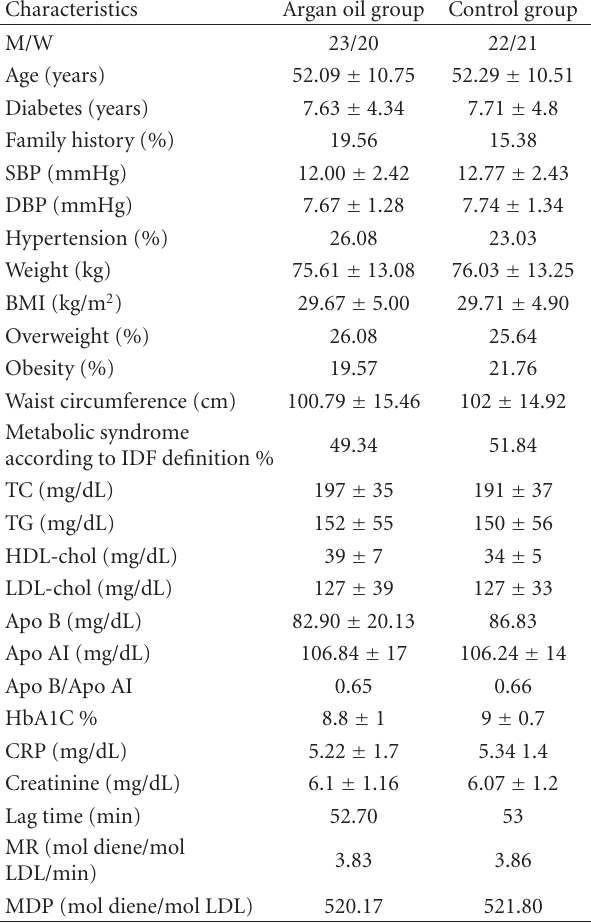
Table 2: Baseline anthropometrical and biological characteristics of both study groups.